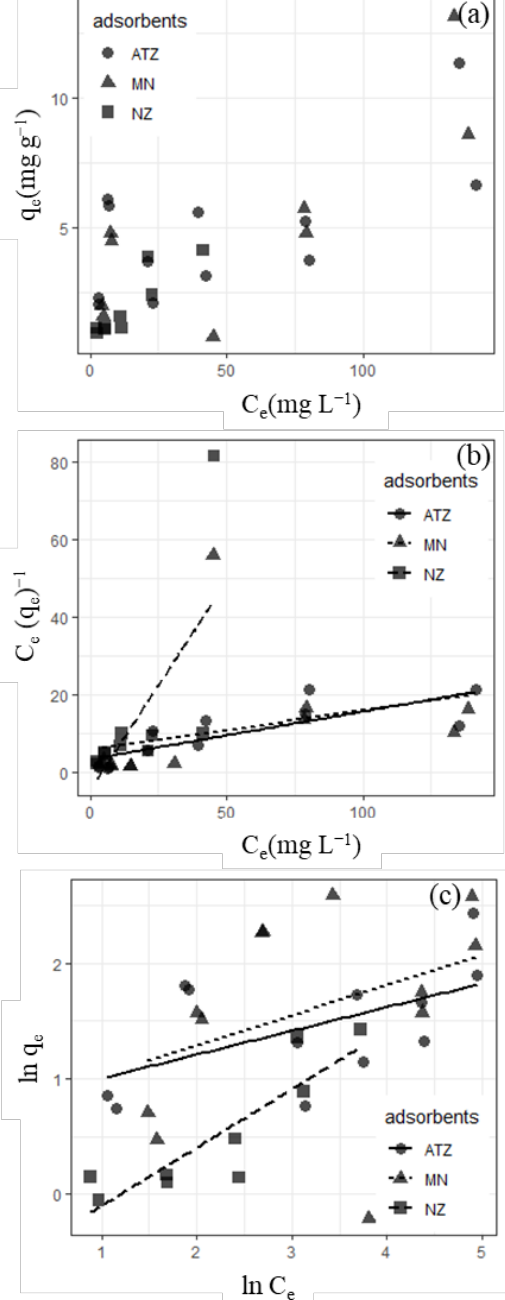
Figure 2. ( a ) Adsorption isotherm; ( b ) Langmuir isotherm; and ( c ) Freundlich isotherm of potassium (K) in potassium chloride (KCl) solutions on natural zeolite (zeolite), ammonium acetate − treated natural zeolite (treated zeolite), and manganese nodule (manganese nodule) at pH 6.99. The K sorption capacities (i.e., q e ) increased with increasing K concentrations at equilibrium (i.e., C e ) (Figure 2a). Considering the R 2 values, the Freundlich